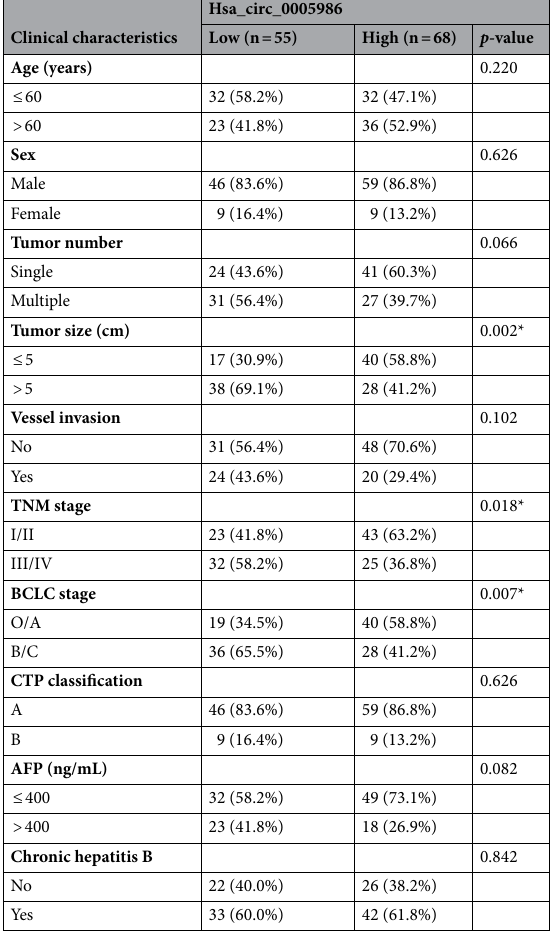
Table 2. Correlation between hsa_circ_0005986 expression and clinical parameters in patients with HCC. TNM tumor node metastasis; BCLC Barcelona Clinic Liver Cancer; CTP Child–Turcotte–Pugh; AFP alpha- fetoprotein. * p <